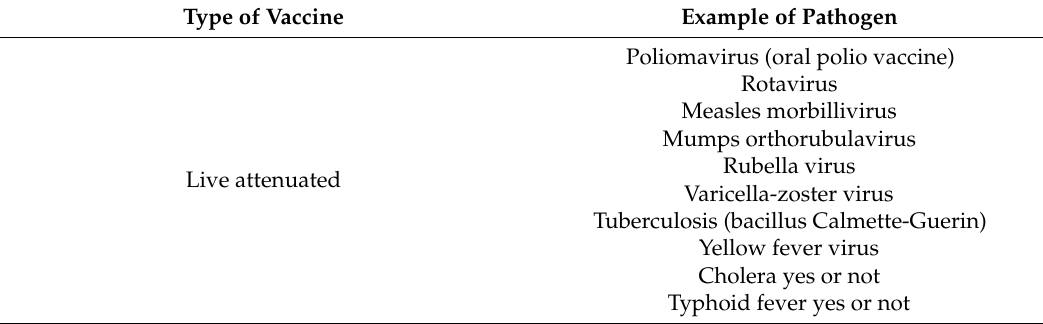
Table 1. Type of vaccines categorized by their composition and